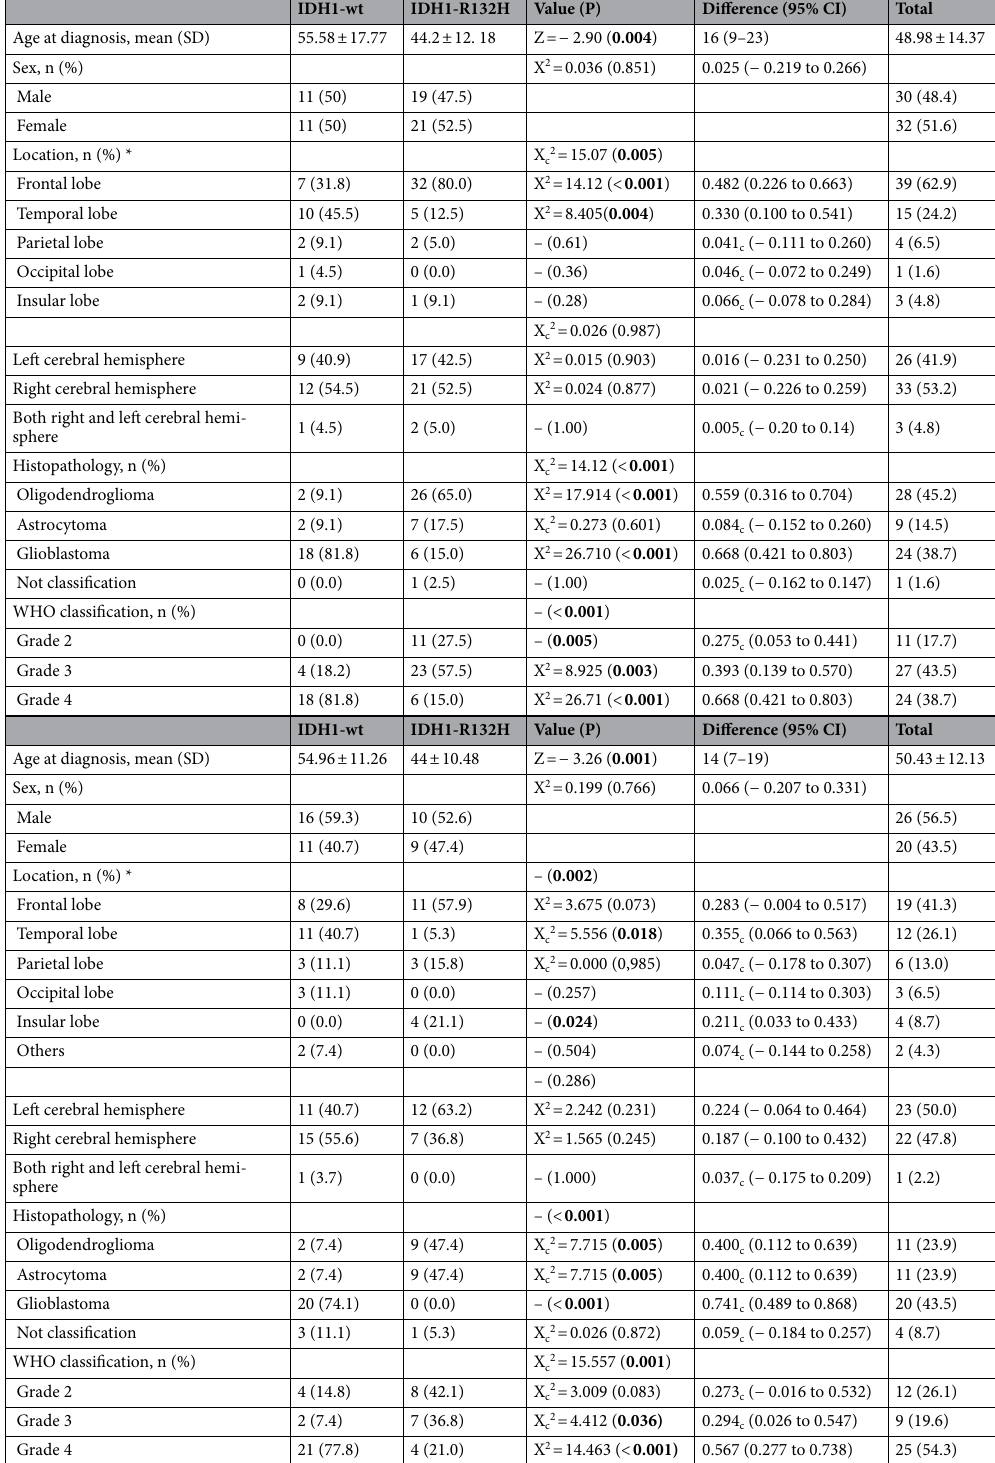
Table 1. Demographic data of enrolled patients. Significant values are in